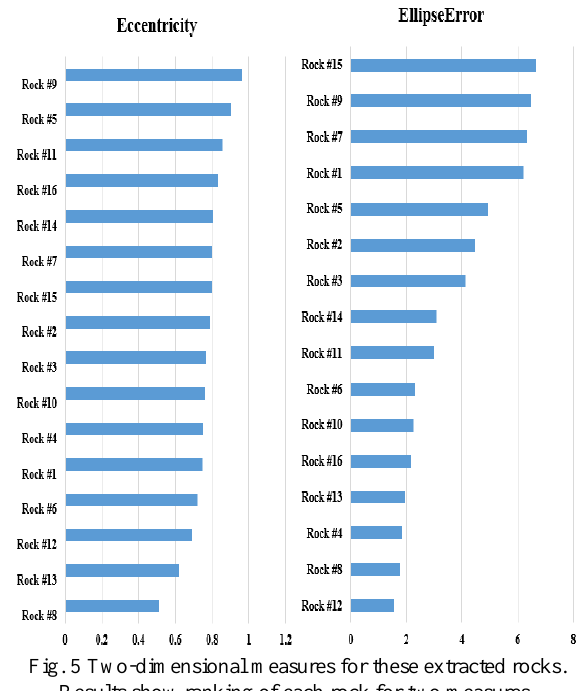
Fig. 5 Two-dimensional measures for these extracted rocks. Results show ranking of each rock for two measures.